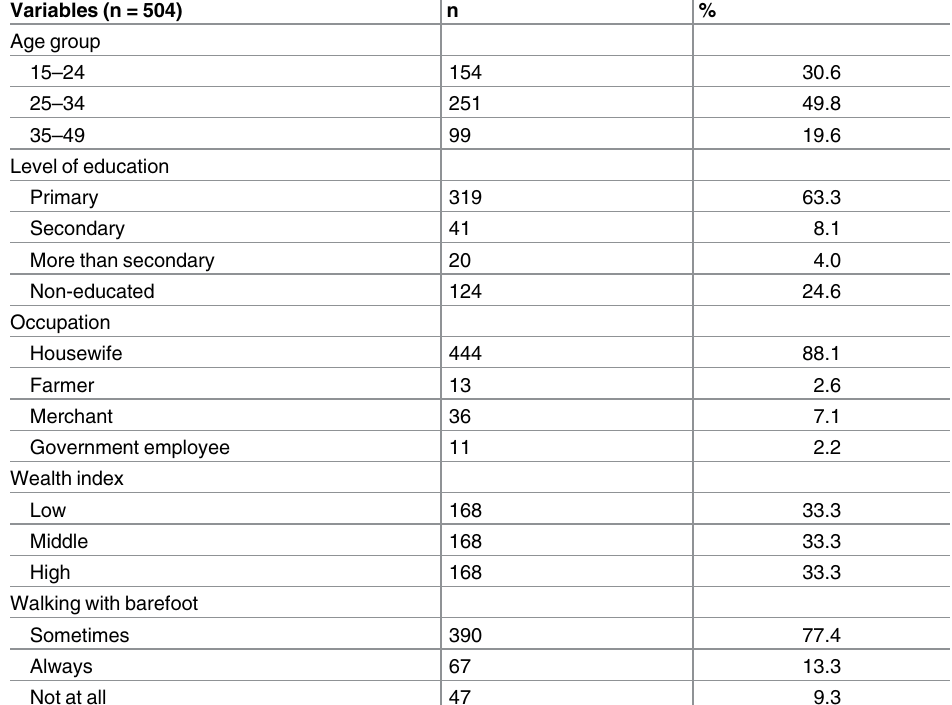
Table 1. Socio-demographic and economic characteristics of pregnant women in Lemo district, Southern Ethiopia, 2015(n =